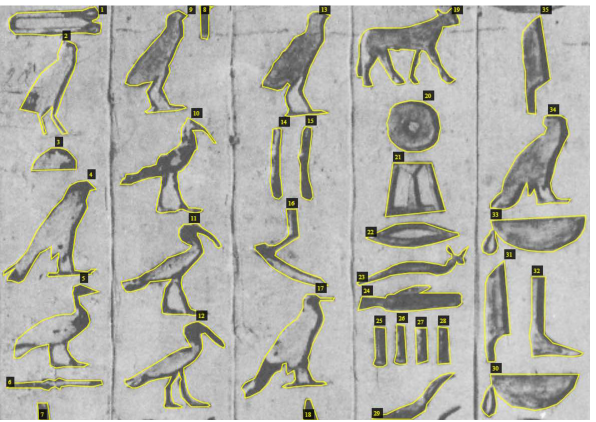
Figure 3. Examples of manual segmentation of the instances of hieroglyphs in an image using a VGG-Image